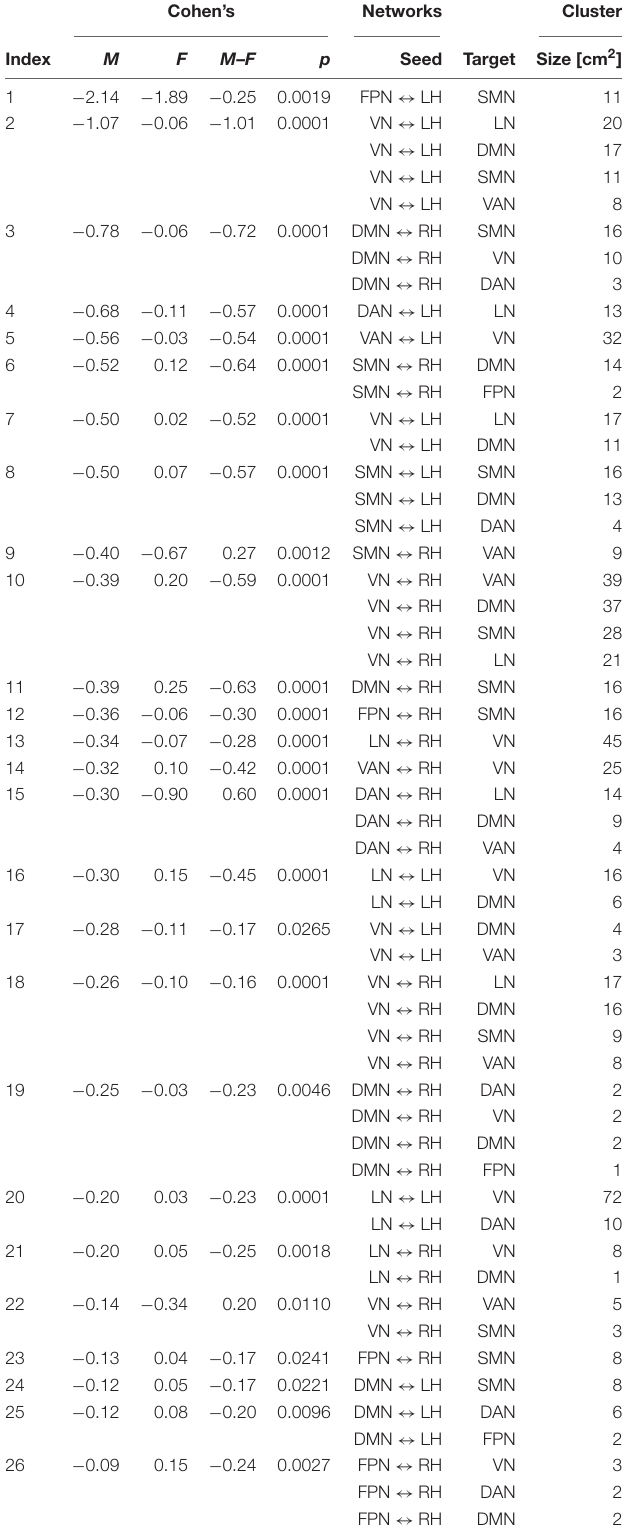
TABLE 4 | Like Table 3 , for FC changes that differ significantly across males (M) and females (F). Cohen’s Networks Cluster